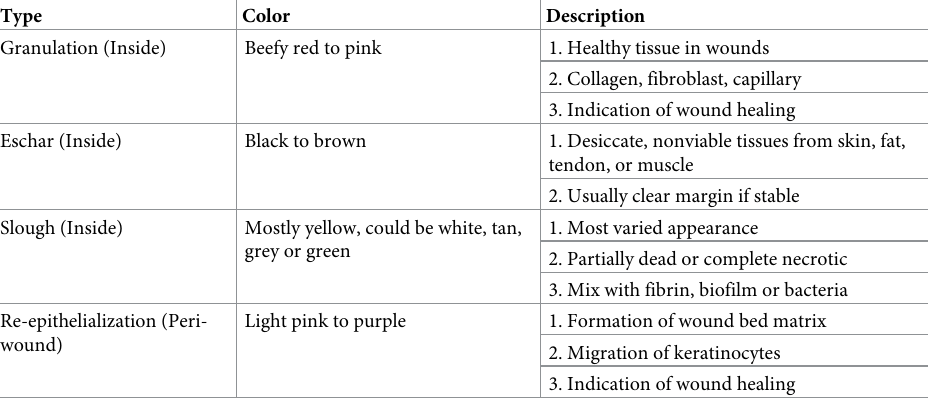
Table 1. Tissues of pressure ulcer inside and